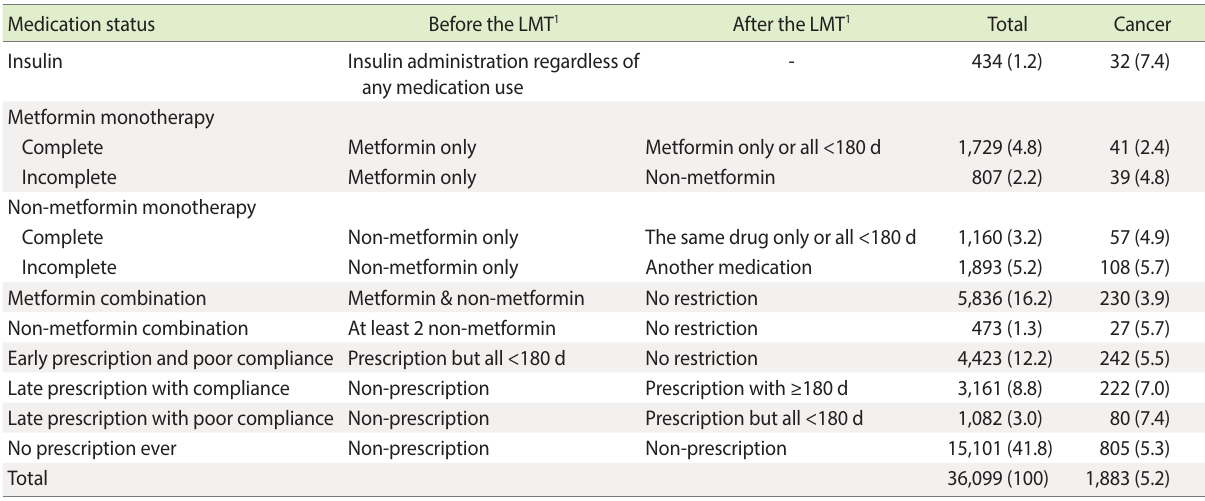
Table 2. Medication prescription status